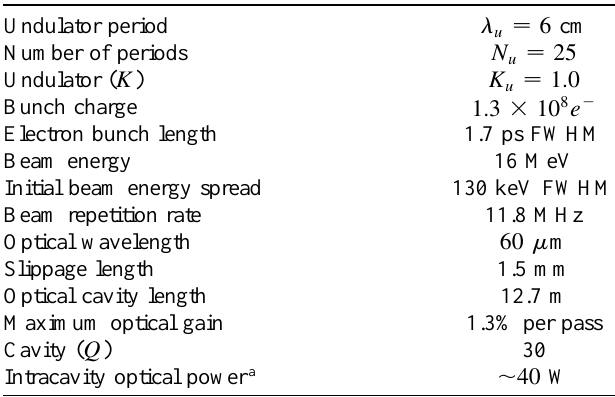
TABLE II. Typical FIREFLY parameters for 60 m m mi- crobunch observations.